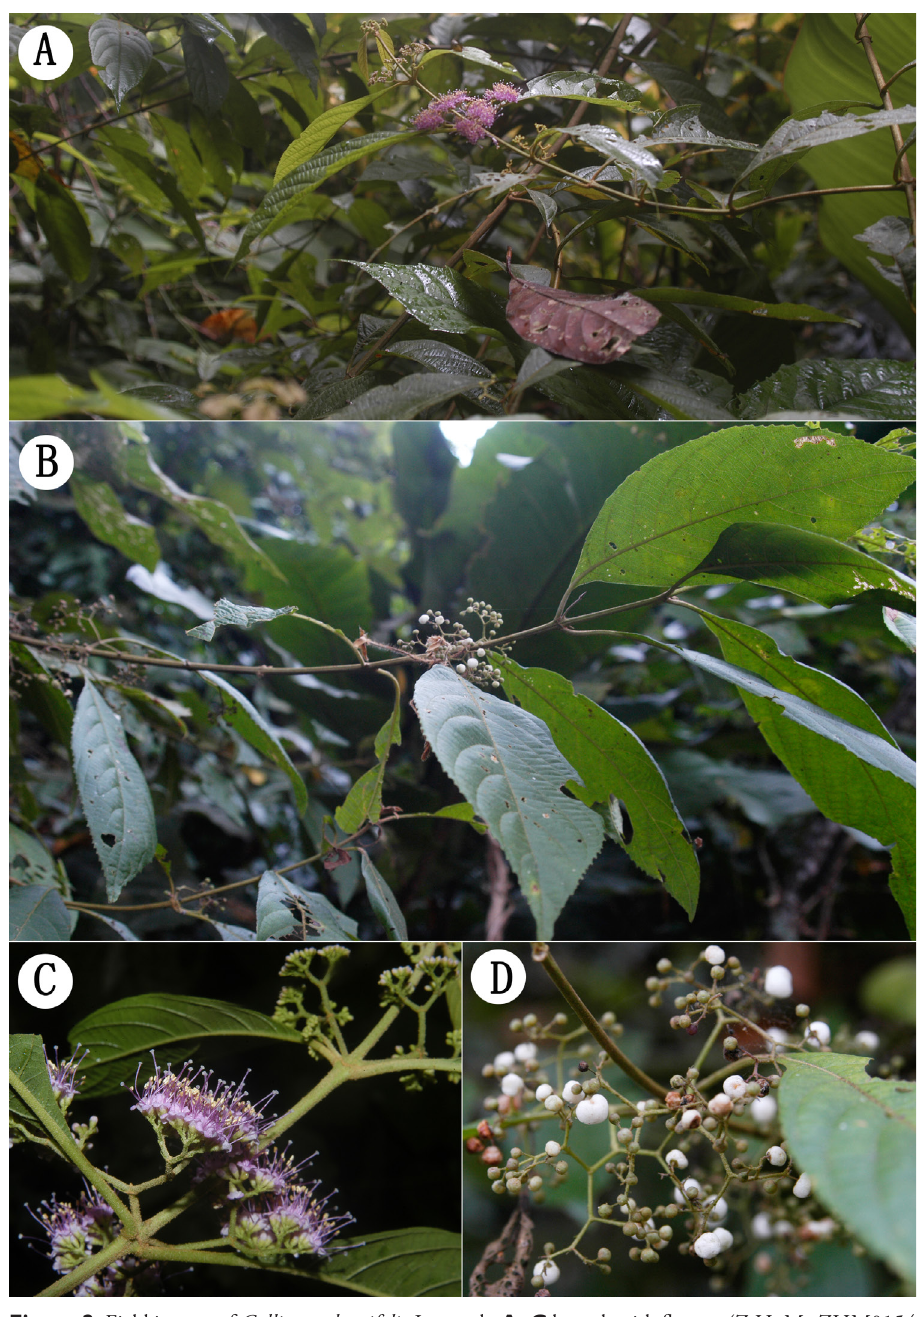
Figure 2. Field images of Callicarpa longifolia Lamarck. A, C branch with flowers (Z.H. Ma ZHM0154 IBSC) B, D branch with white fruits (Z.H. Ma ZHM0117